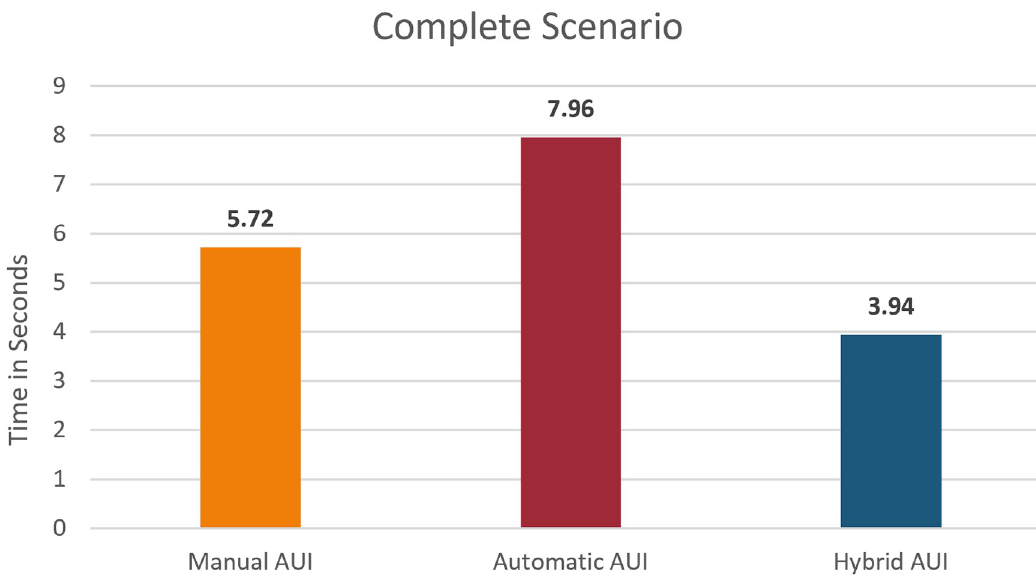
Fig 17. Average completion time for each AUI and all